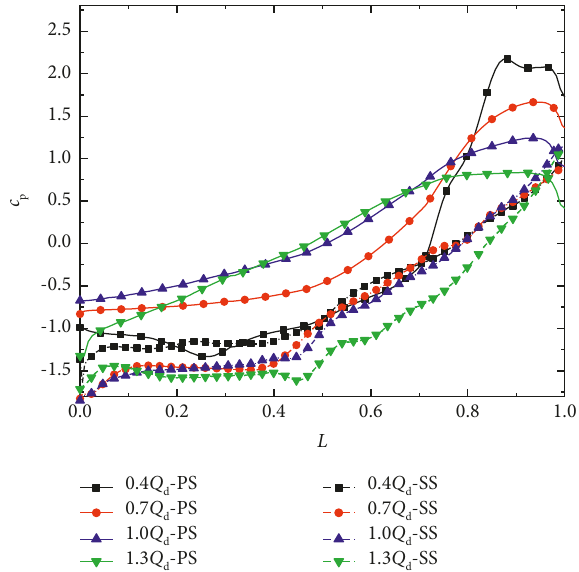
Figure 14: Pressure coefficient distribution of blade surfaces on the center plane.